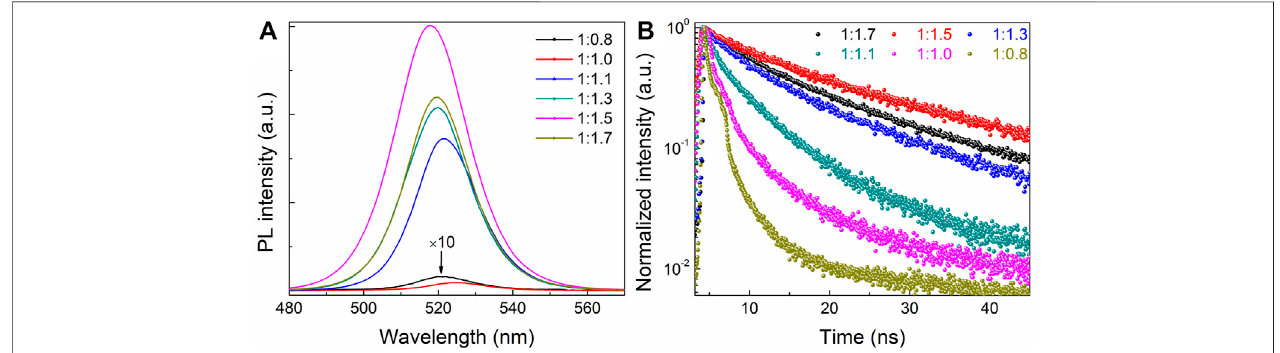
FIGURE 3 | (A) The steady-state PL spectra and (B) time-resolved photoluminescence (TRPL) measurements of the corresponding all-inorganic perovskite fi lms with different molar ratios of PbBr 2 and CsBr, such as 1:0.8, 1:1.0, 1:1.1, 1:1.3, 1:1.5, 1:1.7, respectively.